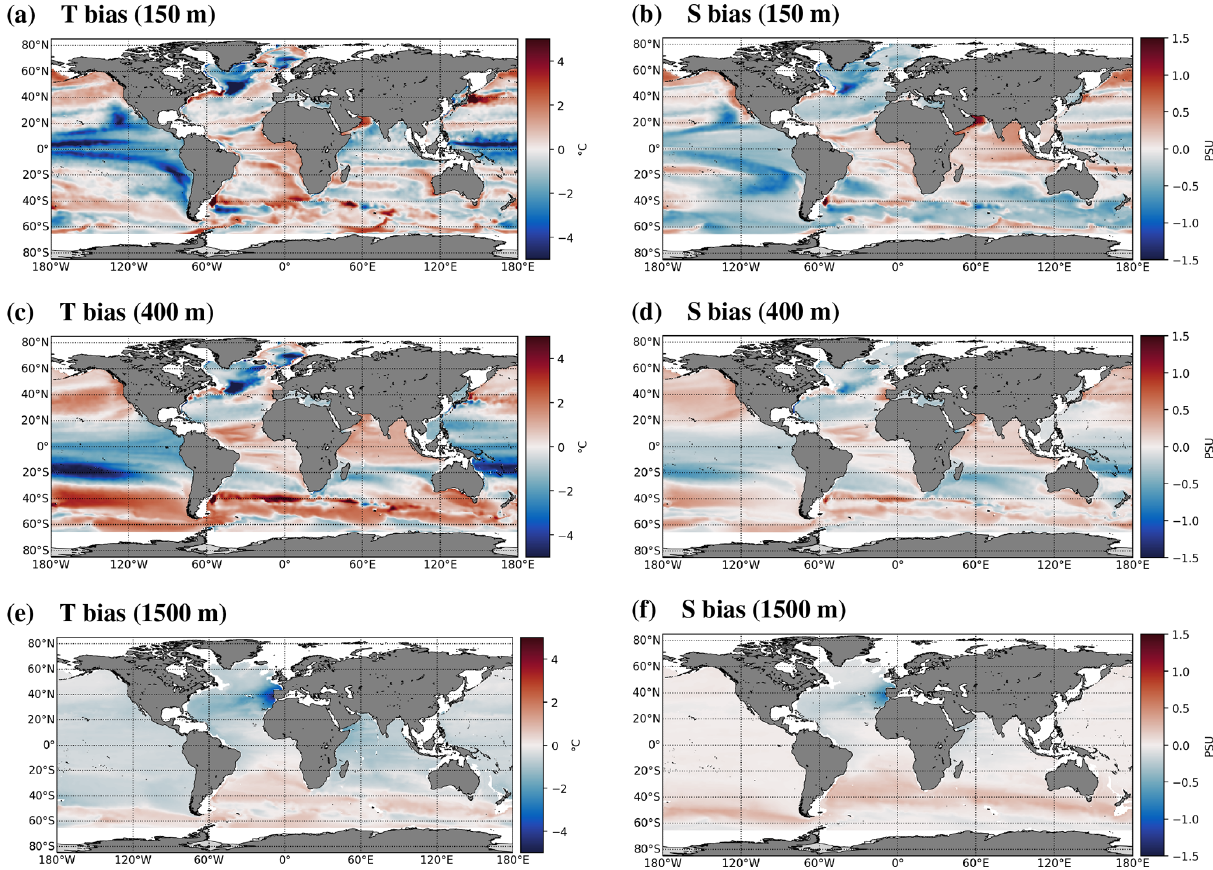
Figure 4. Model minus observation bias for (a, c, e) temperature and (b, d, f) salinity at depths of (a, b) 150m, (c, d) 400m, and (e, f) 1500m. Biases are computed similarly to the lower panels of Fig. 3 and for model climatologies over years